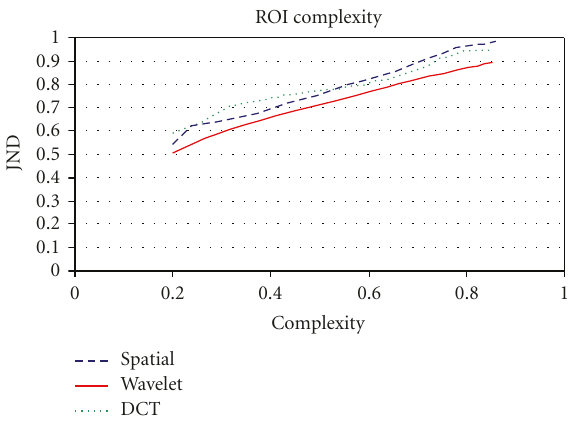
Figure 10: Relation between JND and ROI complexity measure (averaged on 2000